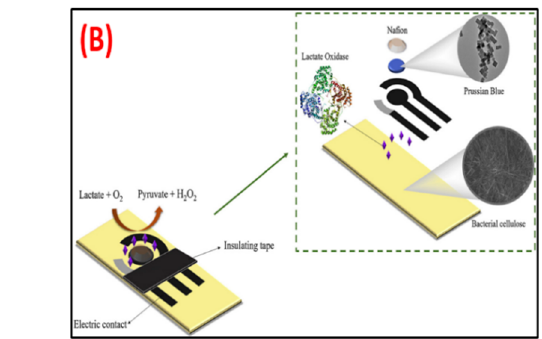
Figure 8. ( A ) Optimized ink-jetted paper device for electroanalytical detection of picric acid [114]. ( B ) Bacterial cellulose-based electrochemical sensing platform for miniaturized biosensors [115]. Re- printed from the above-mentioned references with the permission of copyright from the respective journals.